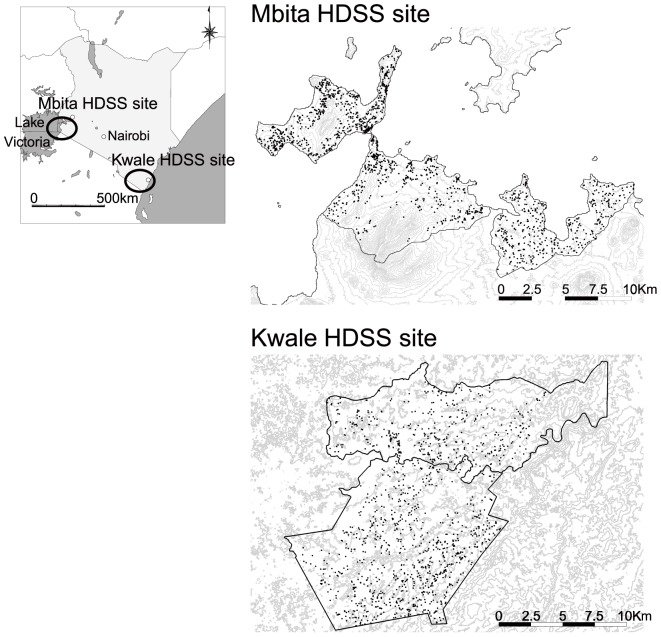
Geographic distribution of sampled populations from the two HDSS sites.Each dot represents individuals selected for the survey. From each HDSS site, 2200 residents were selected by sex and age group. At the Kwale HDSS site, 1453 individuals agreed and participated in blood sample collection. At the Mbita HDSS site, 1958 individuals agreed and participated.